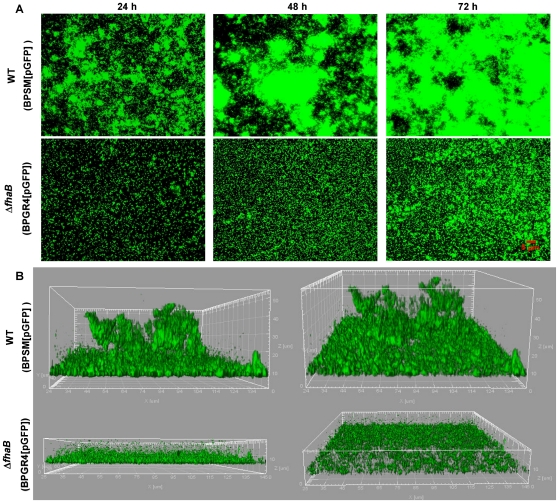
Microscopy analysis of biofilm formation by the WT and the ΔfhaB strains.GFP-tagged strains were inoculated directly in the continuous-flow chambers. Bacteria were allowed to attach for 4 h at 37°C, and then the sterile SS medium was pumped through the flow chambers at a flow rate of 0.1 ml min−1. The experiment was repeated at least three times. Biofilms were visualized in situ by fluorescence and CLSM microscopy. (A) Representative fluorescence micrographs of biofilms taken every 24 h for 3 days at a magnification of ×400. (B) Volumetric 3D reconstructions of representative Z-section image stacks of biofilms taken at 72 h of growth at a magnification of 630×. For each strain, images are presented in two different perspectives.